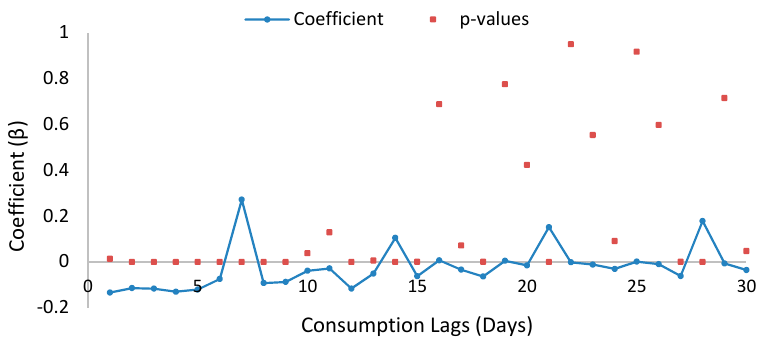
Figure 13. Coefficients of the autoregressive model.